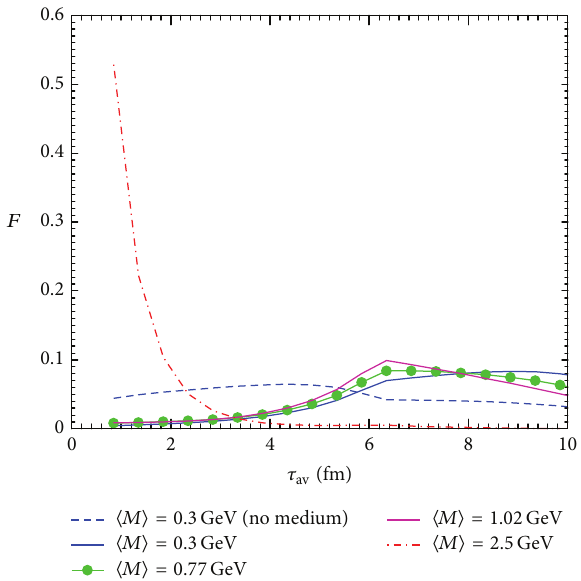
Figure 39: Fractional contribution of lepton pairs for various invariant mass windows as a function of average proper time (see text for details)